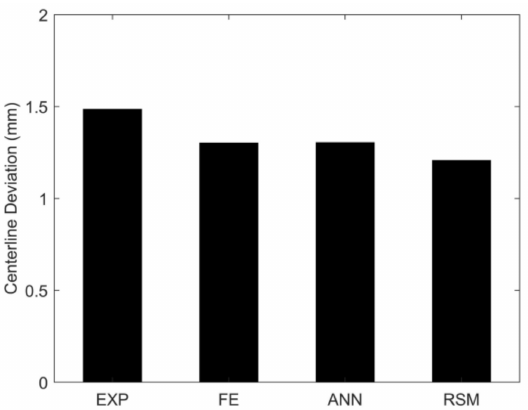
Figure 21. Comparison of the centerline deviation for the no drawbead